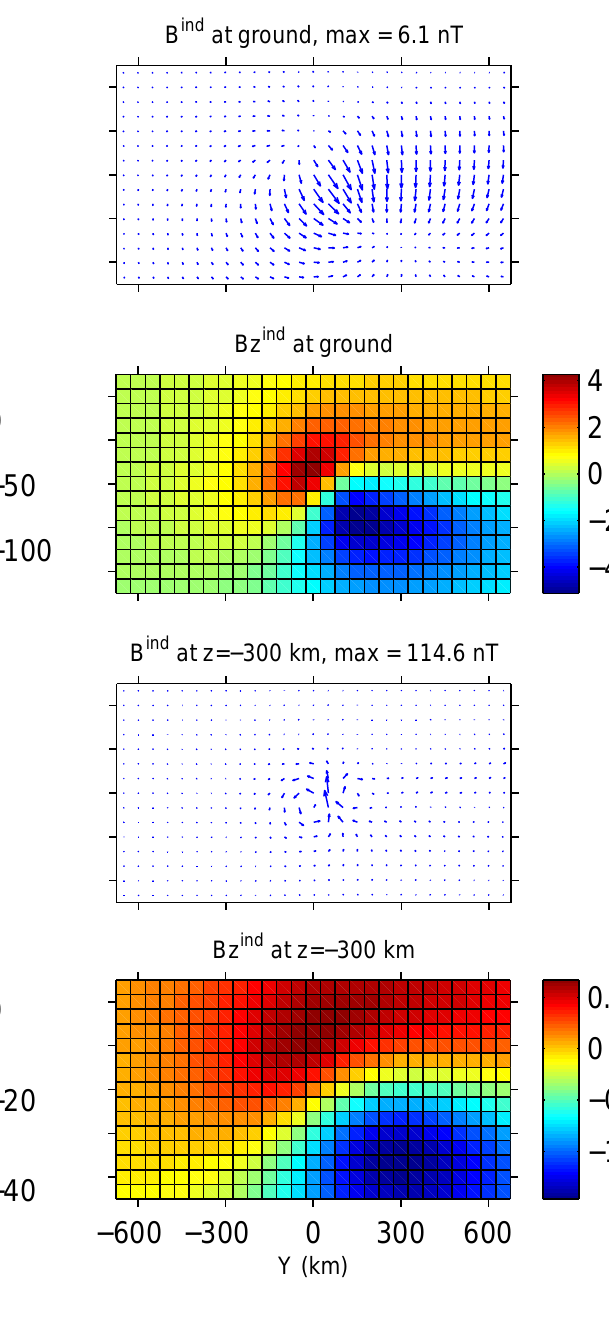
loop, with downward FAC at the eastern and upward FAC at the western part of the surge head. The induced FAC are al- most balanced with a slight upward net current, the integrated downward current over the analysis region being ∼ 90% of the upward current in the same area. In the input model the imbalance is larger, the upward FAC being ∼ 30% larger than the total downward FAC. It is interesting to note that while the induced upward FAC are concentrated at the same areas